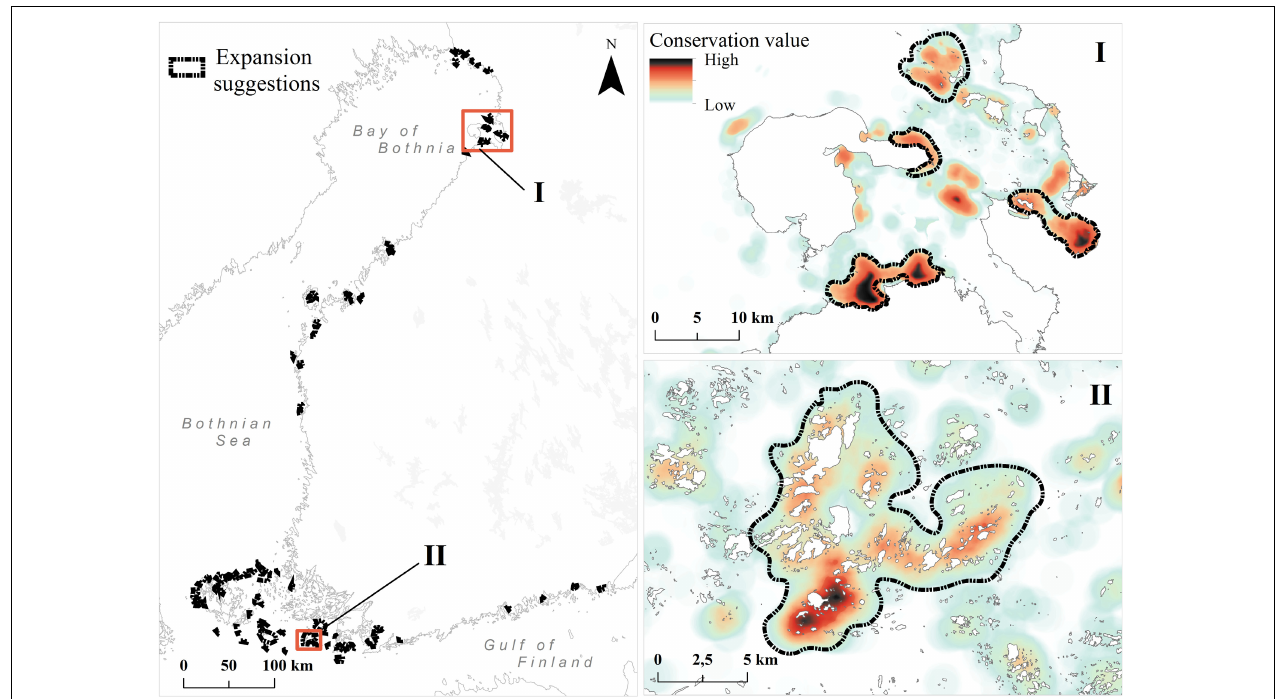
FIGURE 8 | Proposed top 3% MPA expansion areas. Suggestions are based on the product of priority ranks and weighted range-size rarity (see details in section “Analysis Variants and Post-processing”). Zoomed-in example images (I and II) are shown from the northern and southern parts of Finnish marine areas. The color ramp in these areas is different from the previous figures; here the ramp shows internal variation inside the top 3% area fraction. Areas of high conservation value inside the present MPAs are not